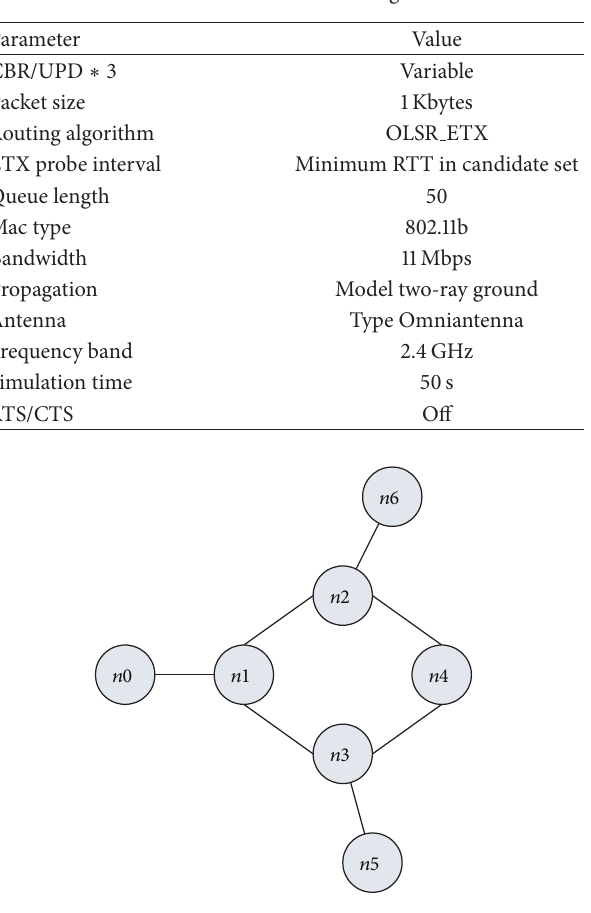
Figure 2: Topology of